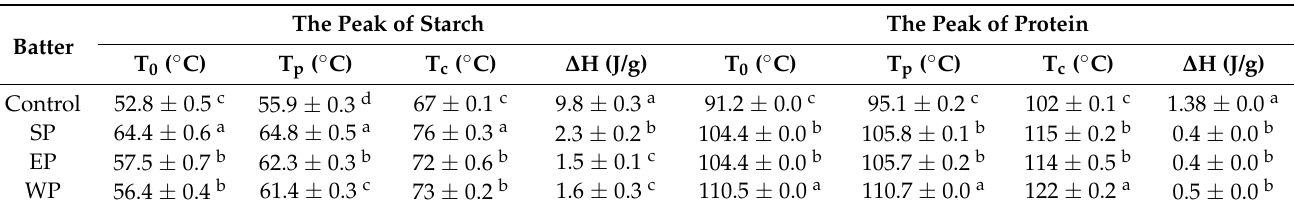
Table 2. Effect of added proteins on the calorimetric parameters of